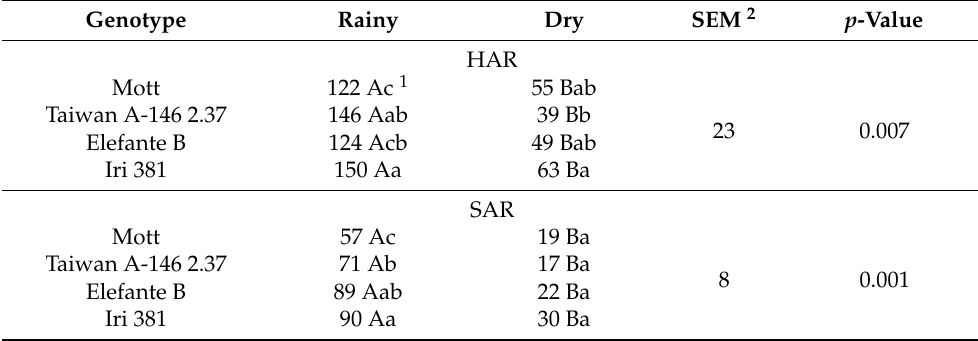
Table 2. Leaf accumulation rate (LAR; kg dry matter/ha per day) as affected by the interaction be- tween genotype and irrigation for elephantgrass genotypes at Garanhuns, Pernambuco, Brazil.